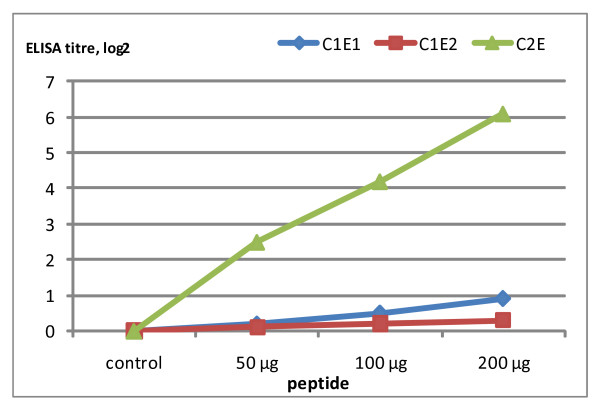
Dose response curve of antibody production in immunized mice. Sera from 5 mice per group were collected 1 week after the last immunization and tested by ELISA for the presence of specific antibodies. The peptides from C1E1 and C1E2 represented amino acids 93-112 of the C1 region, whereas peptides C2E represented amino acids 218-240 of the C2 region. Antibody titers of sera from mice immunized with C1E1, C1E2, and C2E at 50, 100, and 200 μg, are expressed as the log2 values of reciprocal endpoint titers. The control group was injected with normal saline. The immunization by peptides C1E1 and C1E2 induced a poor antibody response, whereas peptide C2E induced a robust antibody response, in a dose dependent manner.